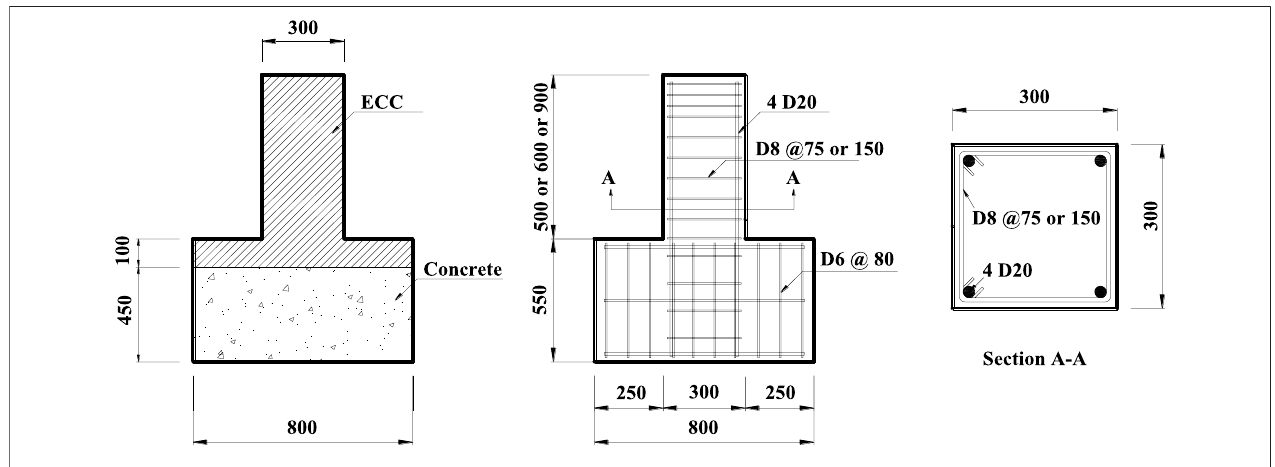
FIGURE 7 | Schematic diagram of an RECC column (unit: mm).